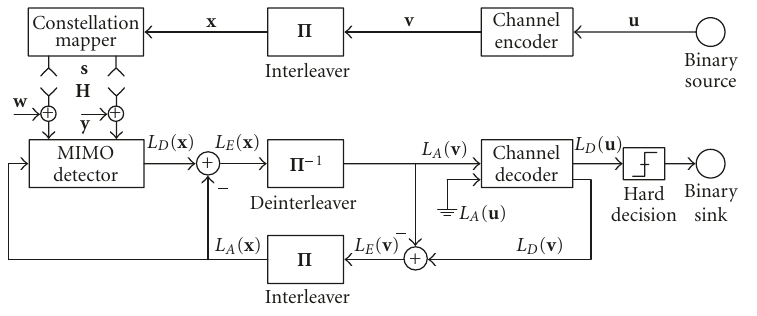
Figure 1: Block diagram of the coded MIMO system with iterative